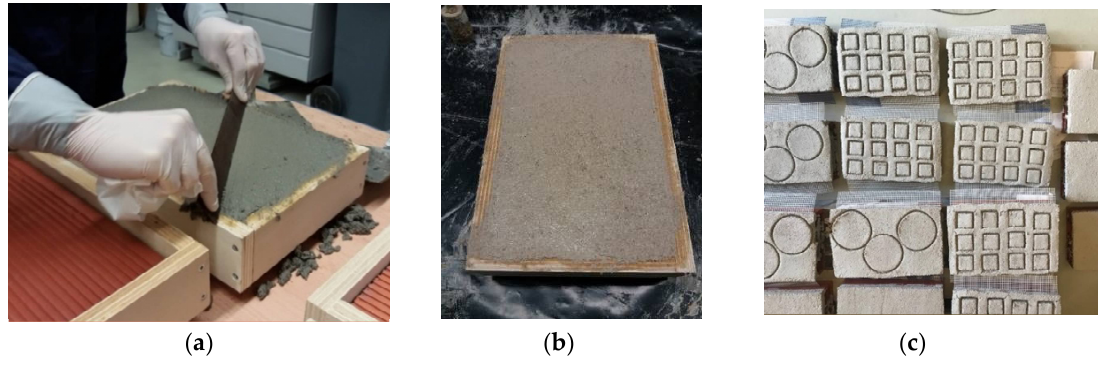
Figure 4. Mortar–substrate specimens: levelling the coating surface ( a ); mortar applied to the substrate ( b ); specimens marked on the coating layer ( c ).